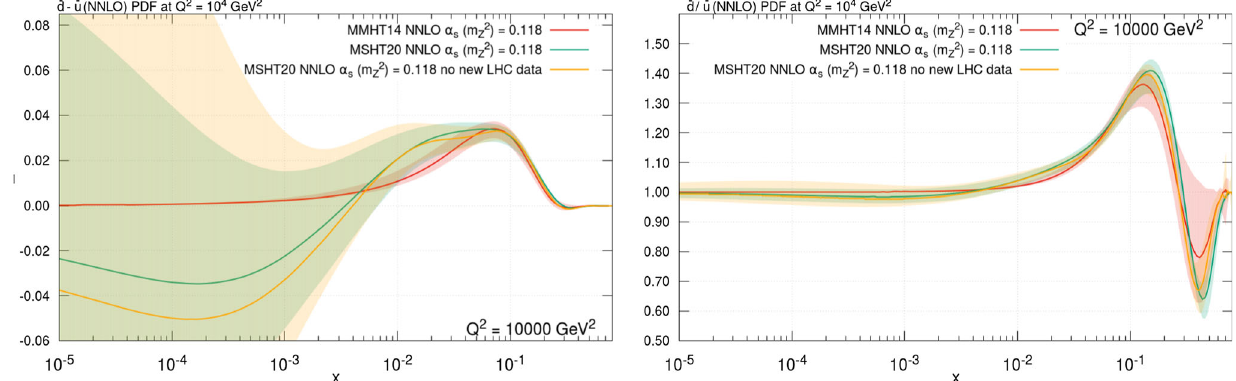
Fig. 47 (Left) Difference and (right) ratio of the ¯ d and ¯ u PDFs at Q 2 = 10 4 GeV 2 at NNLO showing the effect of removing the new LHC data added since MMHT14 on the